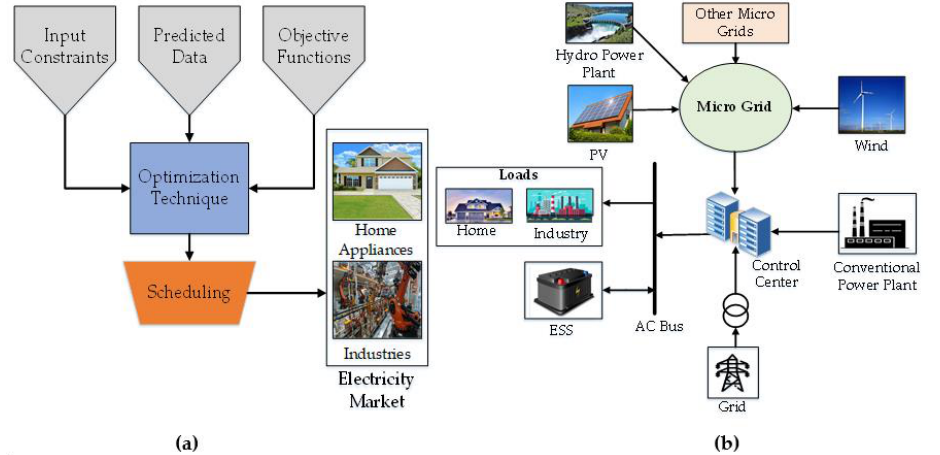
Figure 12. ( a ). Fuzzy based multiple objective optimization algorithms for virtual power plant; ( b ).